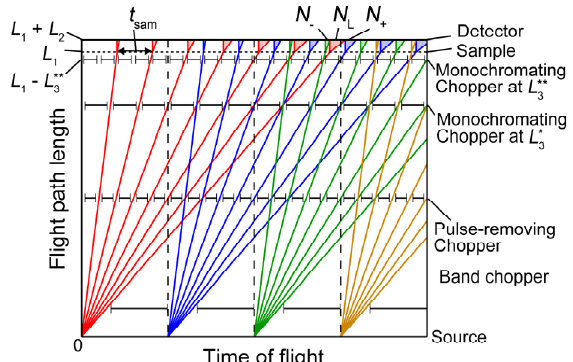
Fig. 5. Example of optimized polychromatic E i measurements considering time spreading of neutrons' arrival time by inelastic scattering. Corresponding parameters are n f = 3, n i = 3, n d = 2, and s = 7 (or s ’ = 2.872). Two possible monochromating chopper positions are shown at L 3* and L 3** . When the monochromating chopper at L 3** is employed, a pulse- removing chopper should be introduced (see text). E i s from the time < 0 are omitted in the